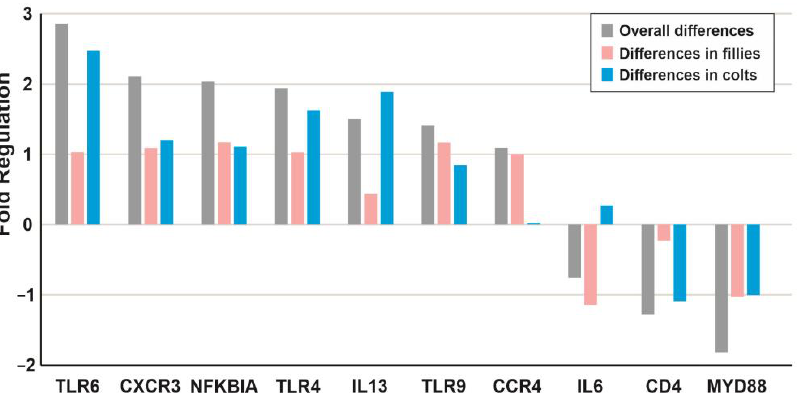
Figure 3. Changes in the transcriptional activity of immune response genes in horses, showing only those that were statistically significant for the overall analysis (both sexes combined) or for each individual sex. The expression before the exercise was set to 0. Significant fold differences were considered to be those greater than +1 or −1 .